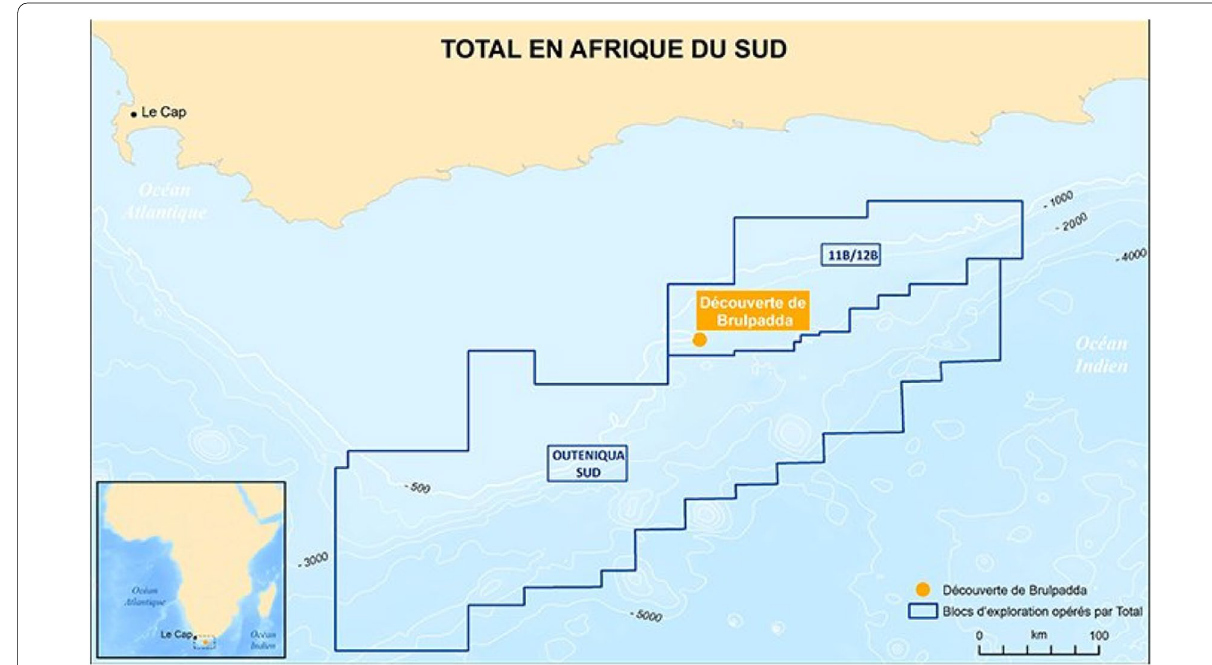
Fig. 1 Area of interest of this study. Main interest Focus on area 11b/12b and Brulpadda point. Credit: